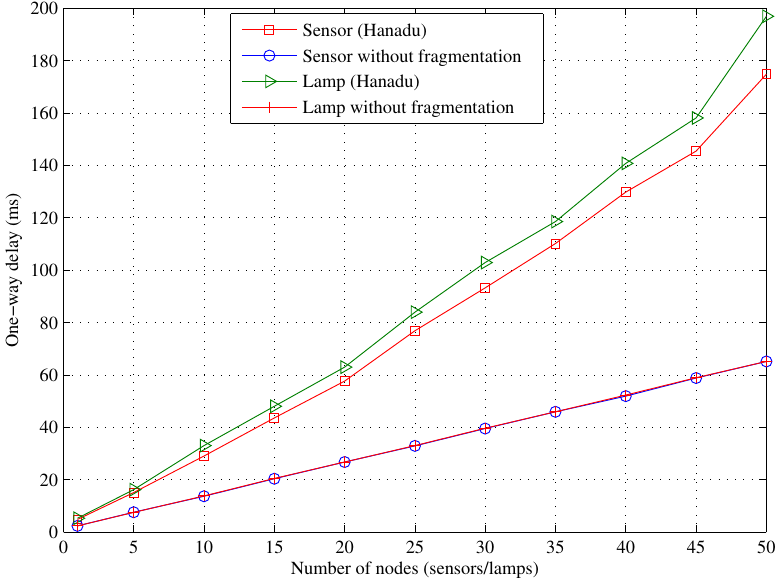
Figure 8. One-way delay for the sensor and